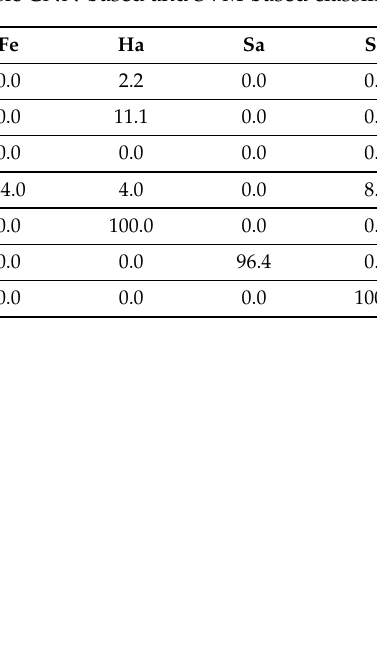
Table 8. Confusion matrix: Weighted summation of basic CNN-based and SVM-based classifiers.